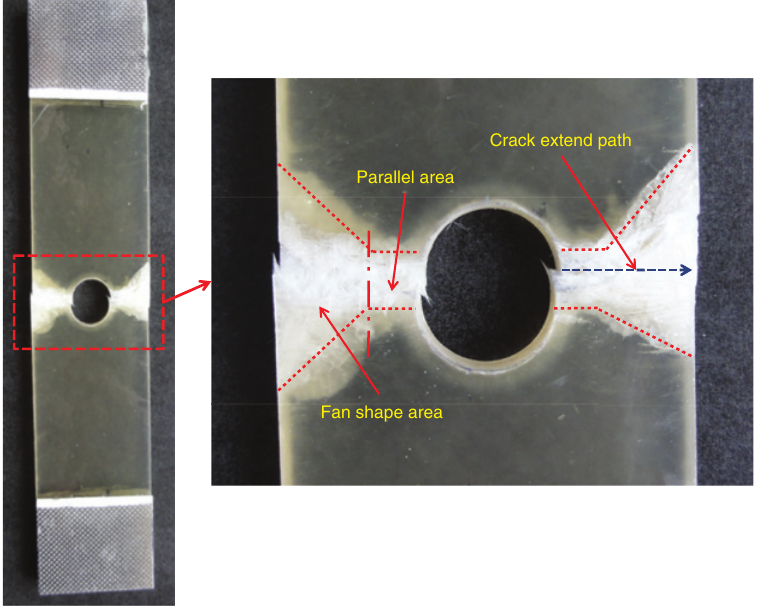
Figure 7 Fracture characteristics of notched specimen which were determined as parallel and fan shape areas.